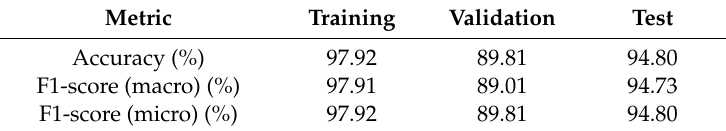
Table 13. Accuracies and F1-scores for training, validation and test predictions.